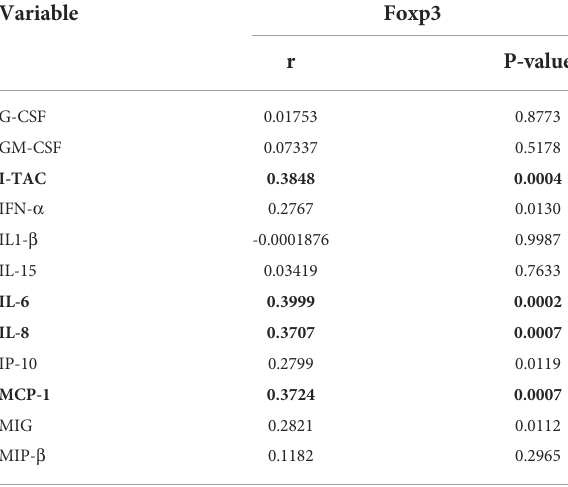
PvalueswereobtainedbySpearmantest(n=80).Boldfontsindicatedstrongcorrelations between the variables and